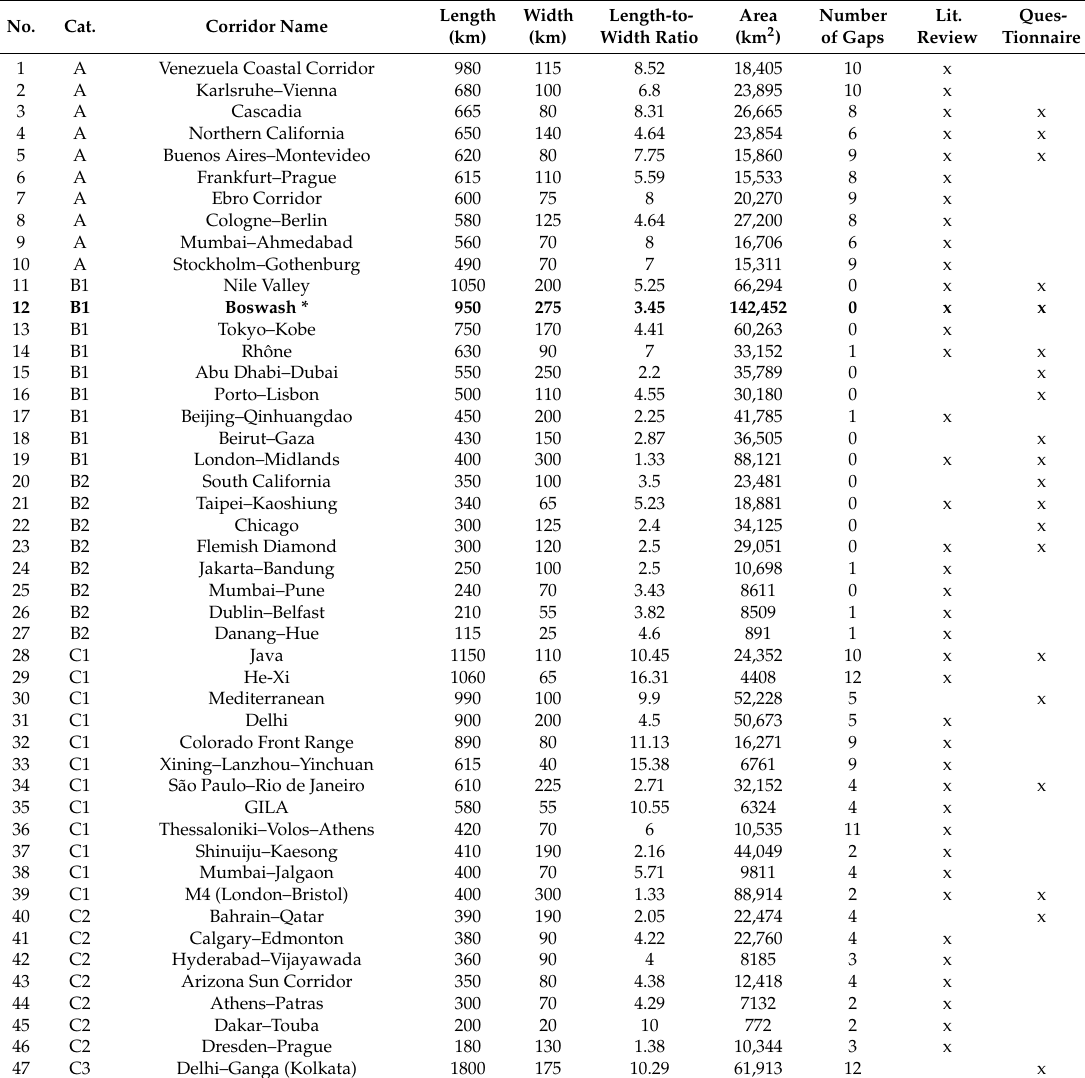
Table 2. Categorization of urban